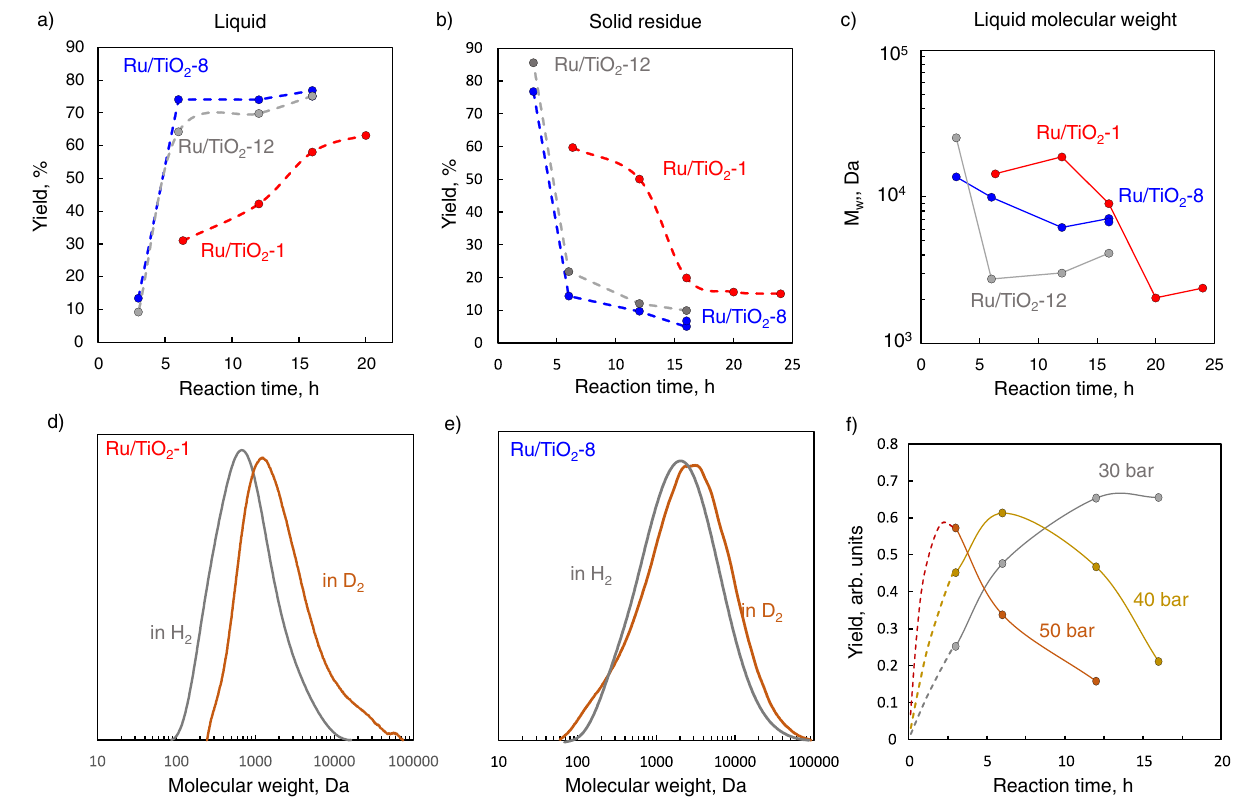
Fig.4|Ru/TiO 2 hydrogenolysisperformanceinPPdeconstruction.a , b Yieldsof liquids ( a ) and solid residue ( b ) vs. time. c M w of liquid vs. time. d , e Effect of substitution of H 2 with D 2 on liquid molecular weight distribution over Ru/TiO 2 -1 ( d ) and Ru/TiO 2 -8 ( e ) catalysts. f Effect of hydrogen pressure on liquid yield over